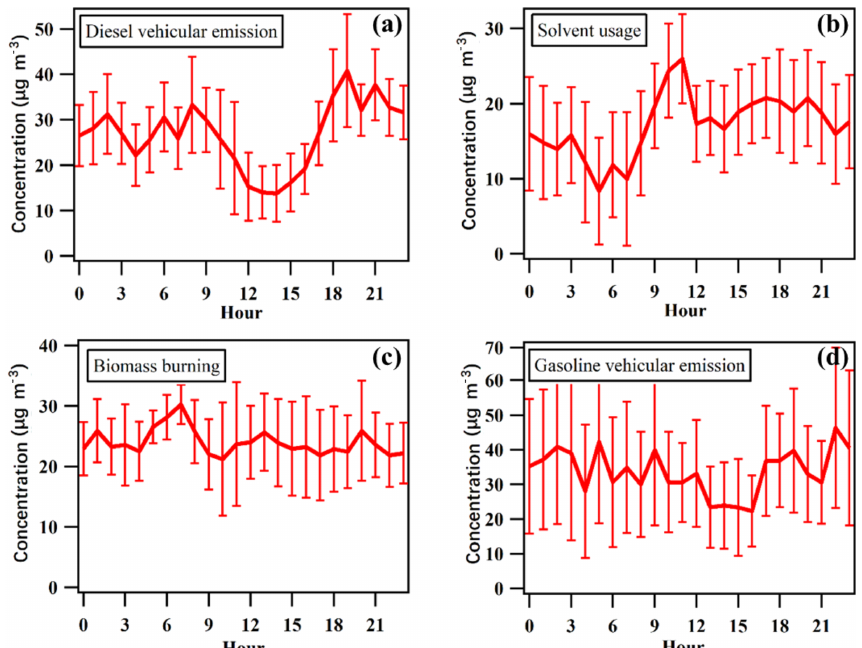
Figure 7. Diurnal variations in volatile organic compounds (VOCs) emitted from different sources extracted from positive matrix factoriza- tion (PMF): (a) diesel vehicular emission, (b) solvent usage, (c) biomass burning and (d) gasoline vehicular